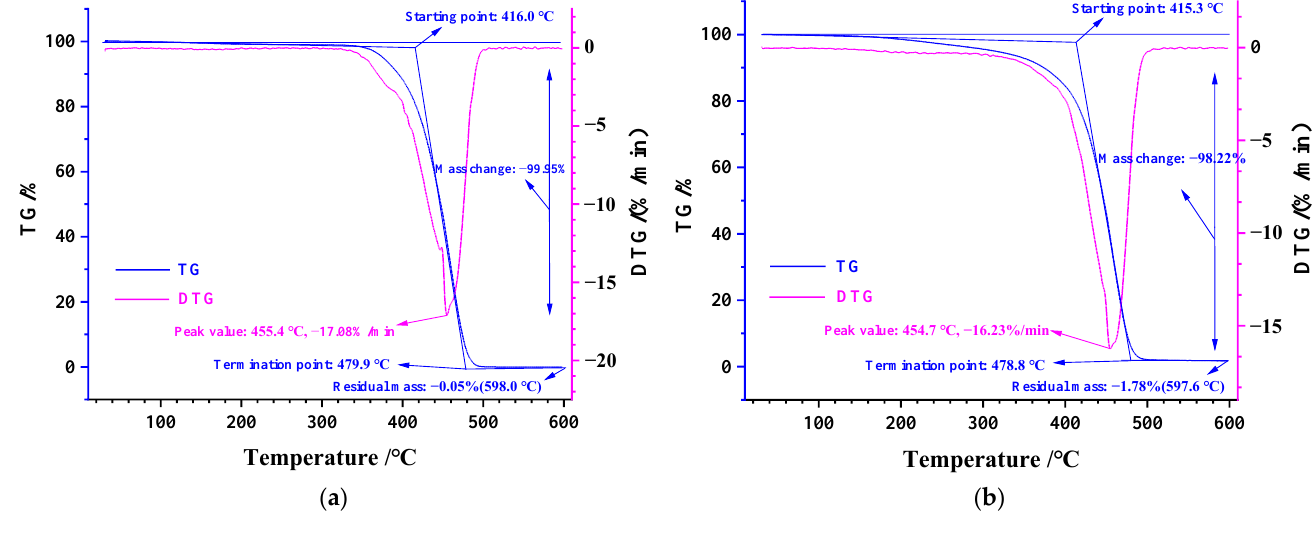
Figure 5. Thermal stability analysis of ( a ) SBS modifier and ( b ) GQDs/SBS composite modifier. Table 2. TG and DTG parameters of SBS modifier and GQDs/SBS composite modifier.